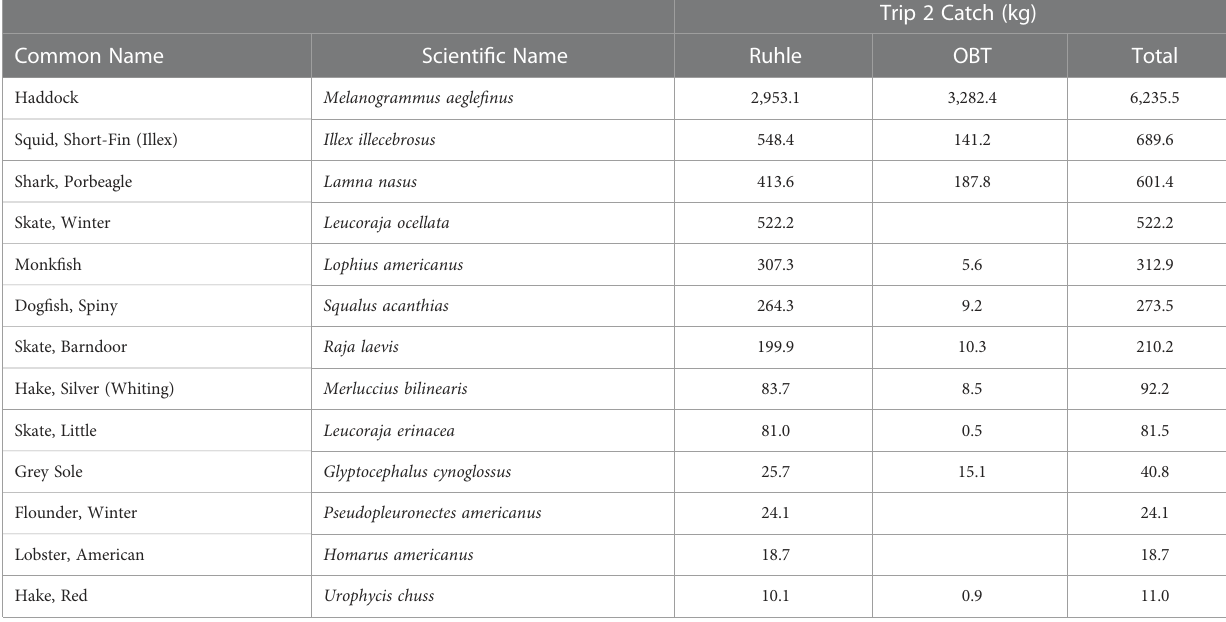
TABLE 3 Trip 2 catch weights (kg) by species and